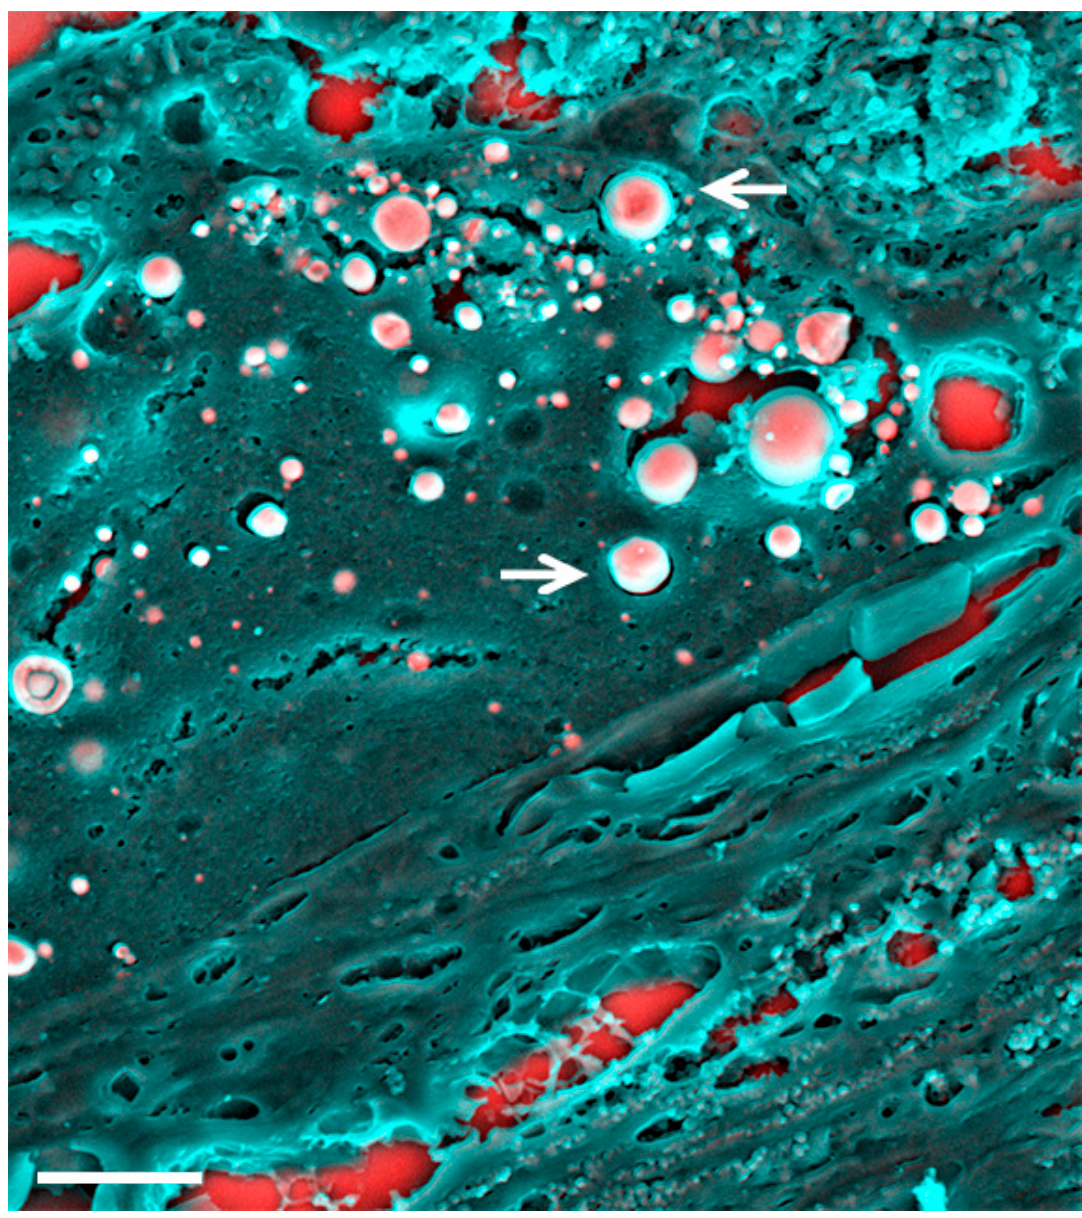
Figure 4. Density-dependent colour-scanning electron micrographs of mineralization observed in the retinal pigment epithelium (RPE). Red and pink indicate inorganic and turquoise (blue/green) indicates organic material. Electron micrograph of spherules (arrows) found in RPE located above Bruch’s membrane. Scale bar = 2 µm.